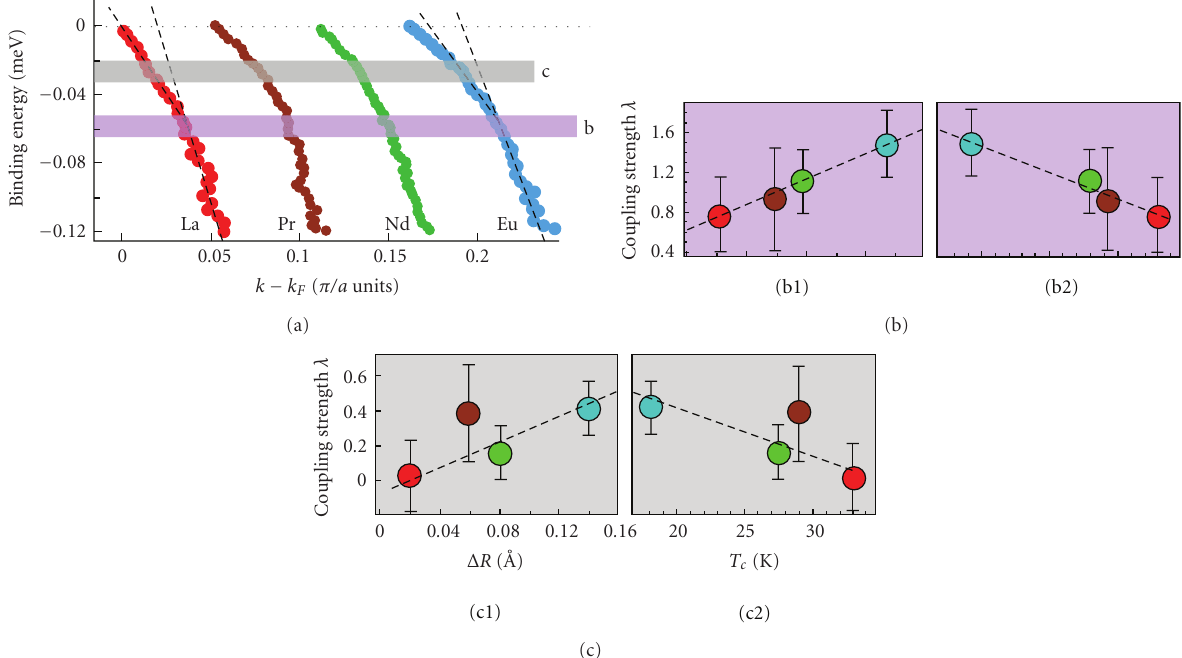
Figure 20: (a) Nodal point MDC dispersions taken from Γ - Y cuts on four di ff erent samples of increasing strain (La, Pr, Nd, and Eu). Lines serve as guides to determine deviation from the expected dispersion. Horizontal shaded regions correspond to the two potential ARPES kink energy scales. (b-c) Estimating the electron coupling λ on the electronic states from each of the two regions indicated in (a). (b1) and (b2) Higher energy kink λ for each strain as a function of (1) Lattice mismatch Δ , and (2) T c . (c1) and (c2) Lower energy kink λ analyzed like